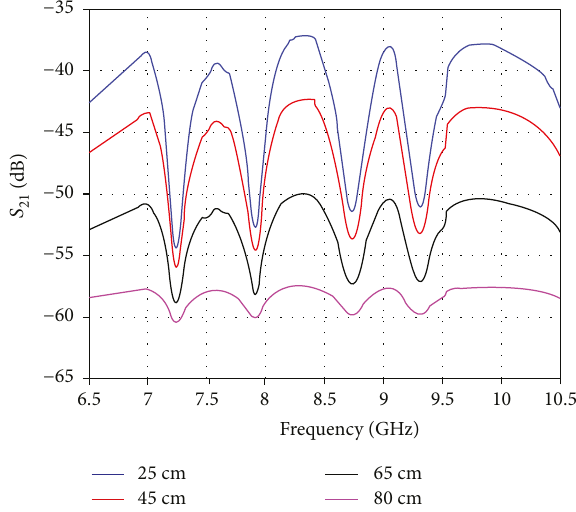
Figure 5: Measured frequency response versus distance for code 010101010 under horizontal